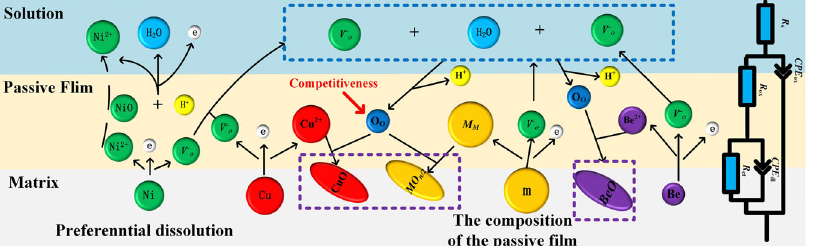
Fig. 11 Schematic illustration of passive fi lm evolution for different alloy samples, which shows transition of the ions, electrons, and vacancies. For convenience, the far right sub fi gure shows the EEC used for fi tting the EIS experimental data.